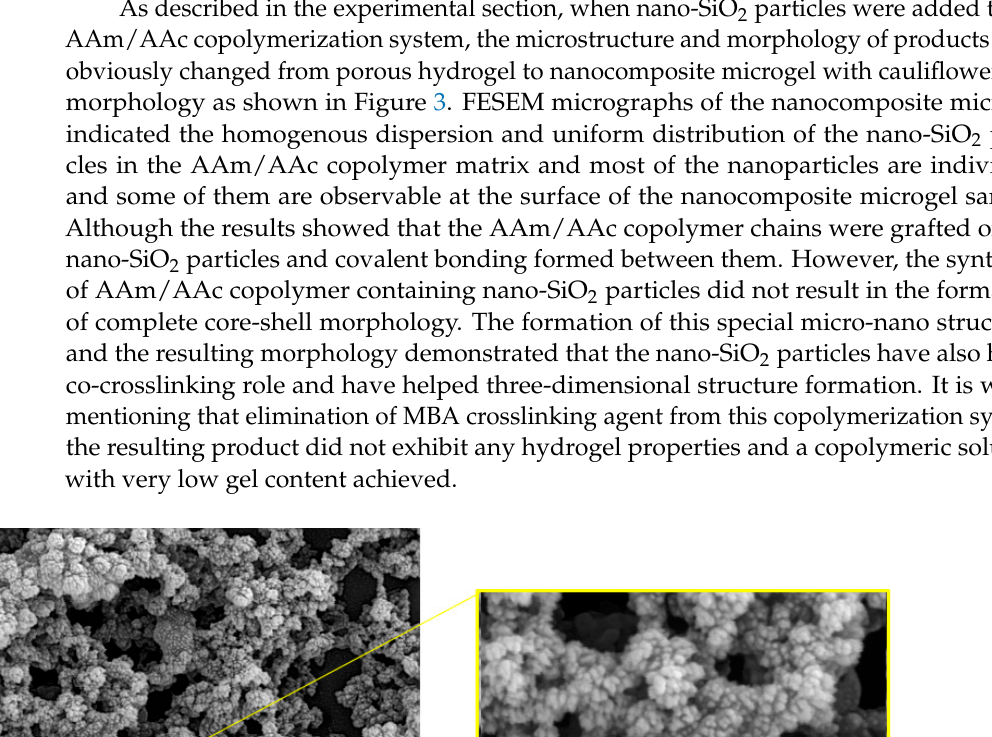
Figure 2. FESEM micrographs of freeze-dried copolymeric hydrogel.